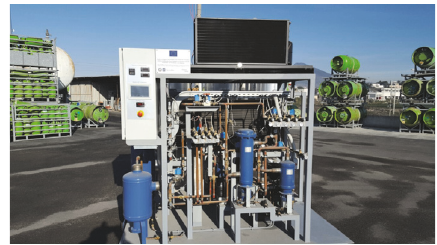
Figure 4: View of the plant subsystem for gas treatment.